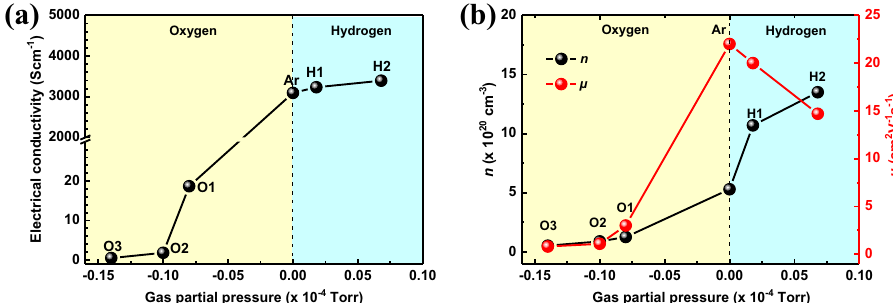
Fig. 2 Electrical properties of thin fi lms grown under different conditions. a Room temperature electrical conductivity. b Carrier concentration ( n ) and mobility ( µ ) of ITO fi lms deposited under a pure argon environment, or at different hydrogen or oxygen partial